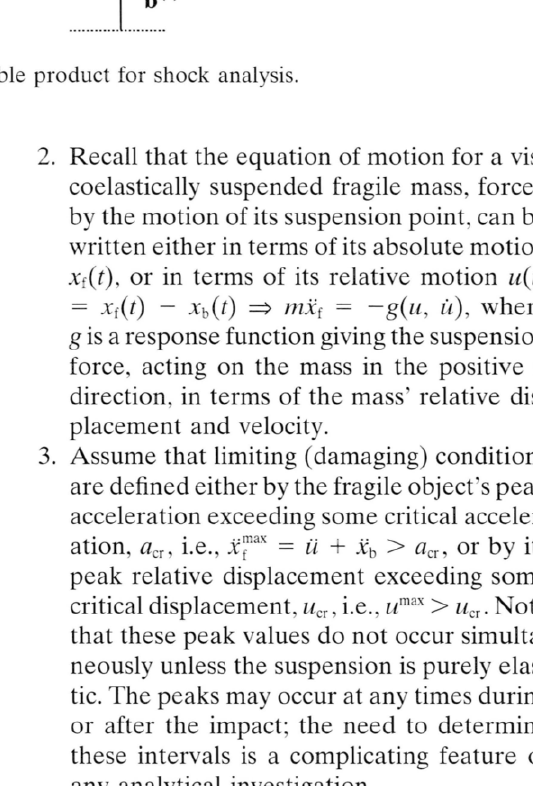
FIGURE 1 Schematic of a portable product for shock